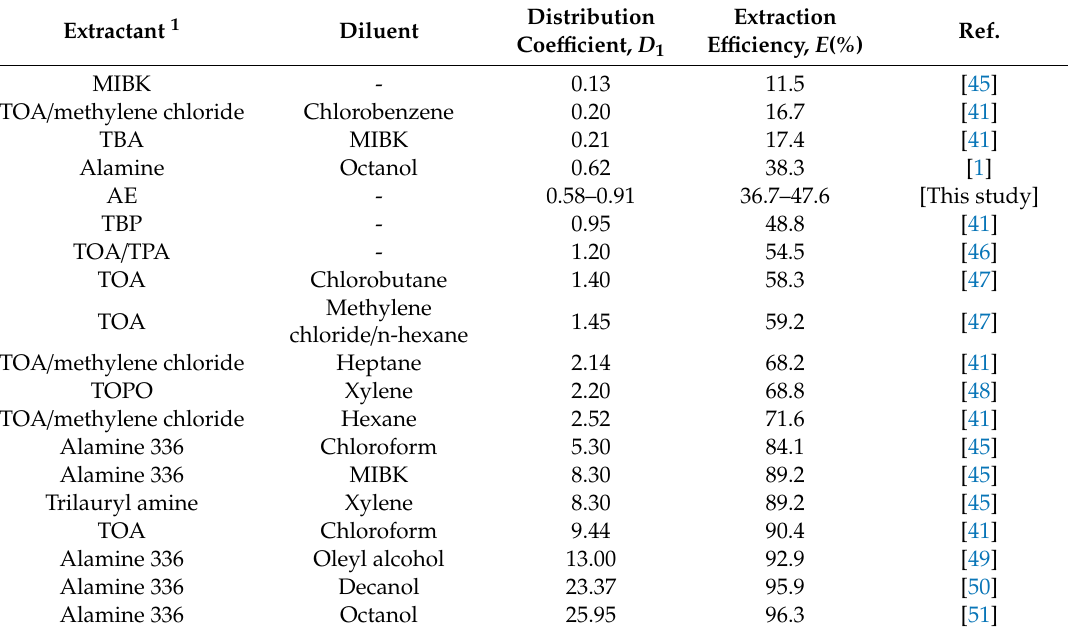
Table 4. Comparison of solvents for extraction of lactic acid from aqueous